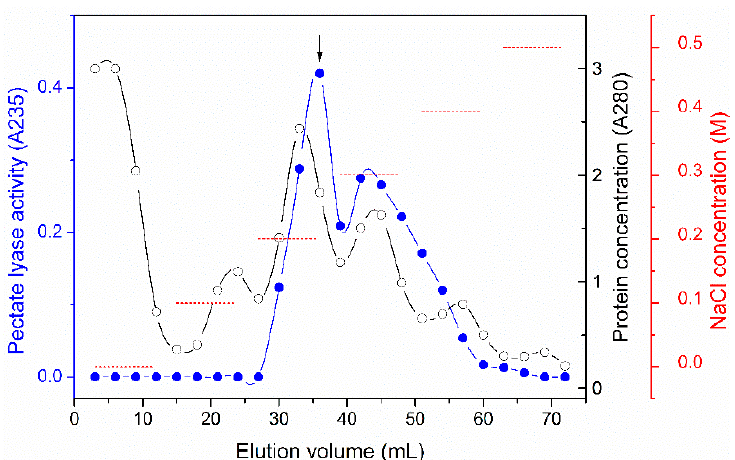
Figure 1. Elution profile of pectate lyase from P. polymyxa KF-1 culture broth by SP Sepharose fast-flow column chromatography. (- -) Pectate lyase activity (A235); (- -) protein concentration determined by absorbance at 280 nm (A280); (—-) NaCl concentration. The arrow indicates the fraction used for LC-MS/MS analysis. Table 1. Pectate lyases identified from P. polymyxa KF-1 by LC-MS/MS analysis. Identified Peptide